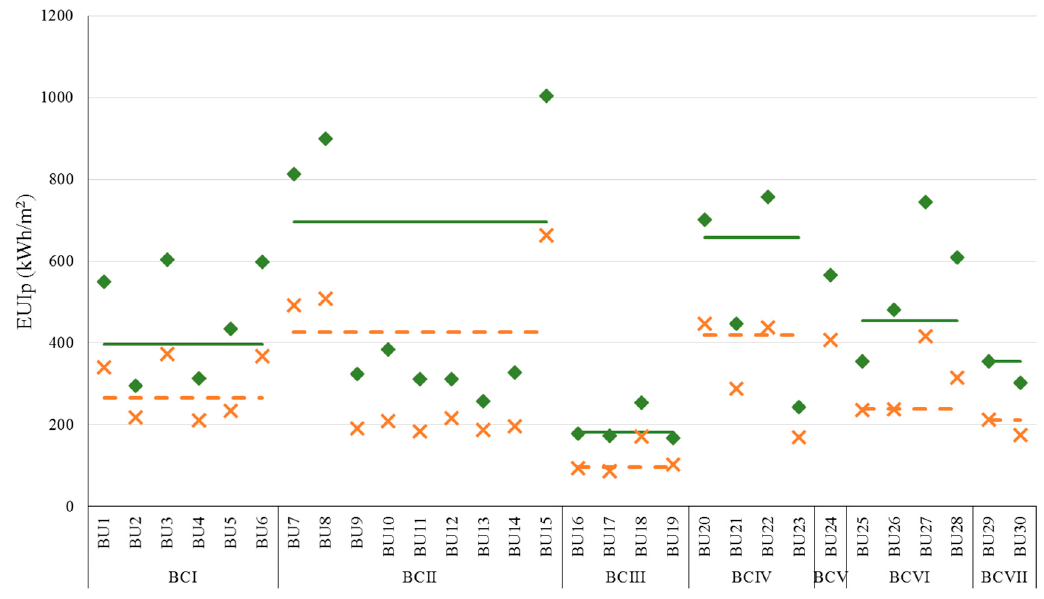
Figure 9. Calculated average total primary energy use intensity for the various building uses (diamond) and for the reference building of each BU (cross). The weighted average for the various building categories is presented with the green solid line and for the reference buildings with the orange dash line.